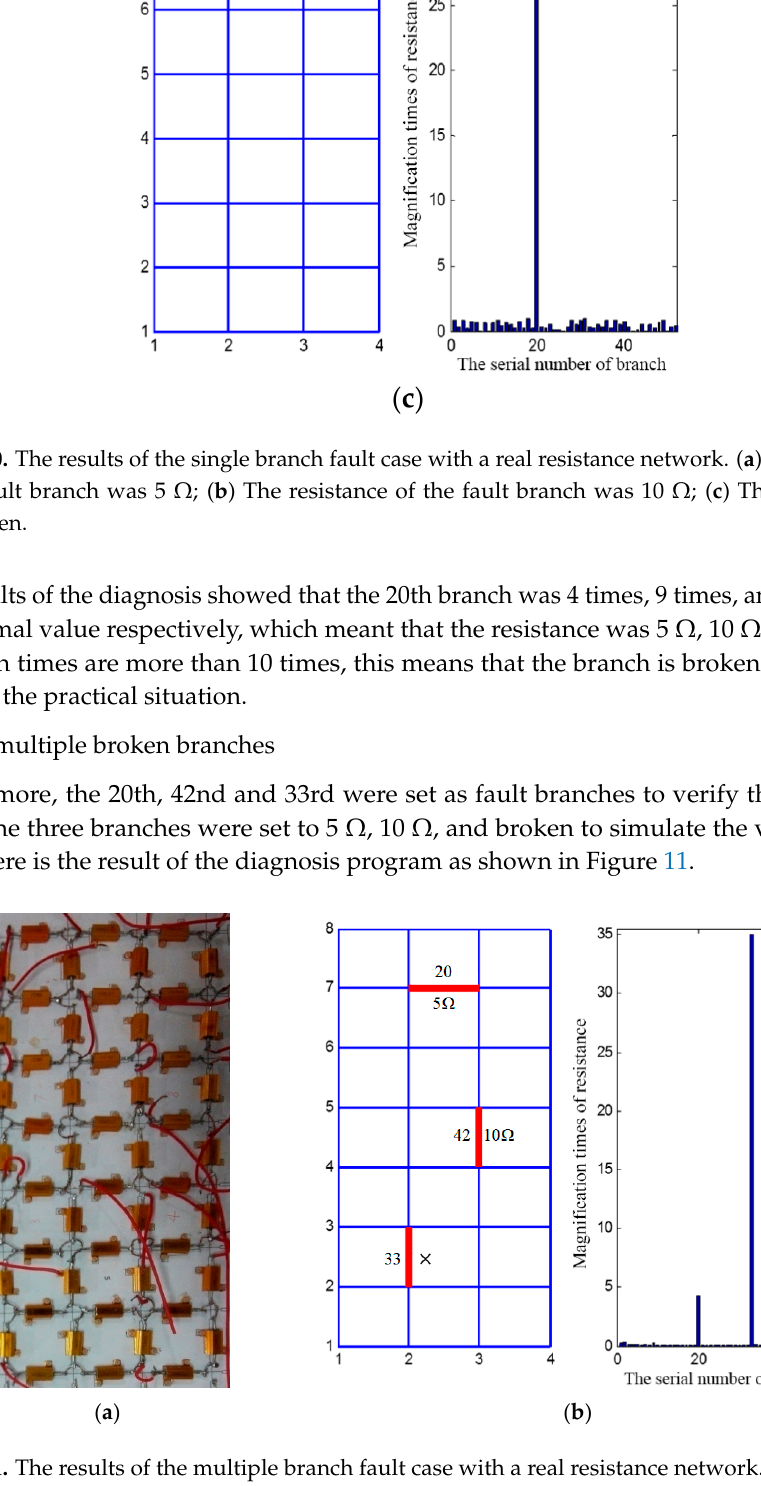
( b ) Figure 11. The results of the multiple branch fault case with a real resistance network. ( a ) Resistance network; ( b ) Diagnosis result. 3.1.2. Tests with Galvanized Steel Strap